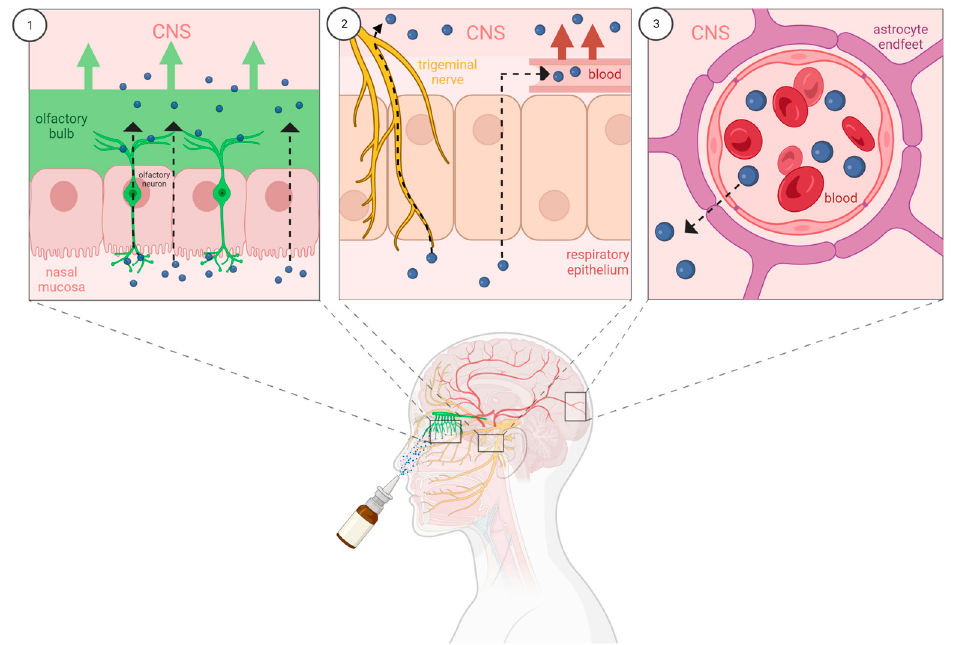
Figure 4. (1) Direct transport of intranasal drugs from the nasal mucosa to the olfactory bulb can occur by axonal transport along olfactory neurons or para- or transcellular transport across the nasal epithelium. (2) In the respiratory region of the nasal cavity, drugs can be endocytosed by the trigeminal nerve and travel along the axon to reach the CNS or can cross epithelial cells to reach the blood. (3) Once in the blood, drugs administered intranasally must cross the BBB to reach the CNS [108] (Created in BioRender.com; accessed on 2 February 2023).